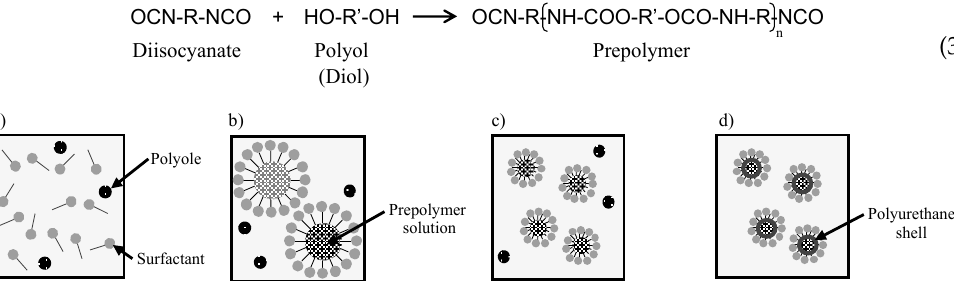
Figure 2. Schematic illustration of the formation of spherical capsules containing healing agent. ( a ) Polyol and surfactant solution. ( b ) Formation of prepolymer micelles by dripping prepolymer solution into ( a ). ( c ) Formation of small prepolymer micelles by vigorous agitation. ( d ) Formation of spherical capsules consisting of polyurethane shell and self-healing agent content.